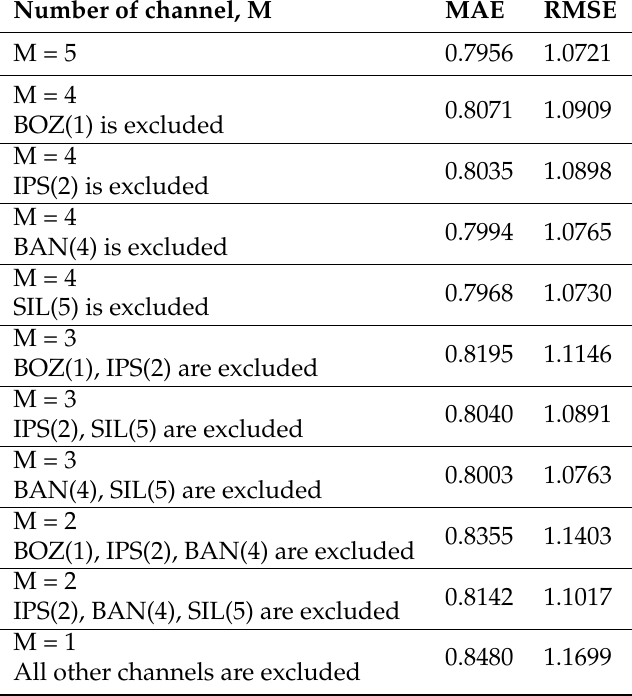
Table 2. RMSE and MAE performances of MARMA-2 for different M when m = 3 (GON), ∆ = 2 and P =